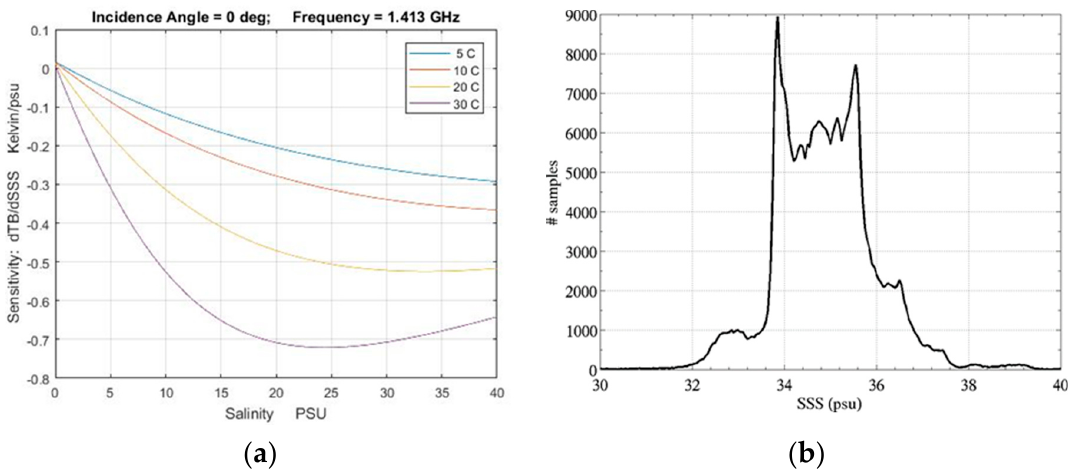
Figure 5. ( a ) Sensitivity of change in brightness temperature to a change in salinity, dTB/dSSS, as a function of salinity for several temperatures. This curve is for 1.413 GHz at normal incidence and no roughness. Based on the Klein-Swift [19] model function; ( b ) Histogram of number of samples for each salinity reported by Argo floats near Aquarius footprints for the period 2011–2015.